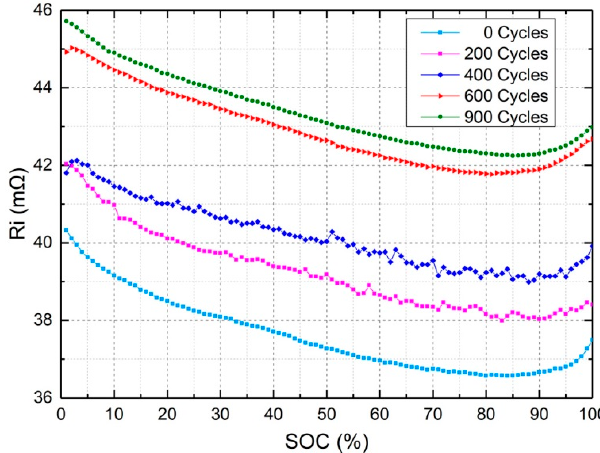
Figure 6. R i -SOC plot with different cycles. Figure 6 . R i -SOC plot with different cycles.